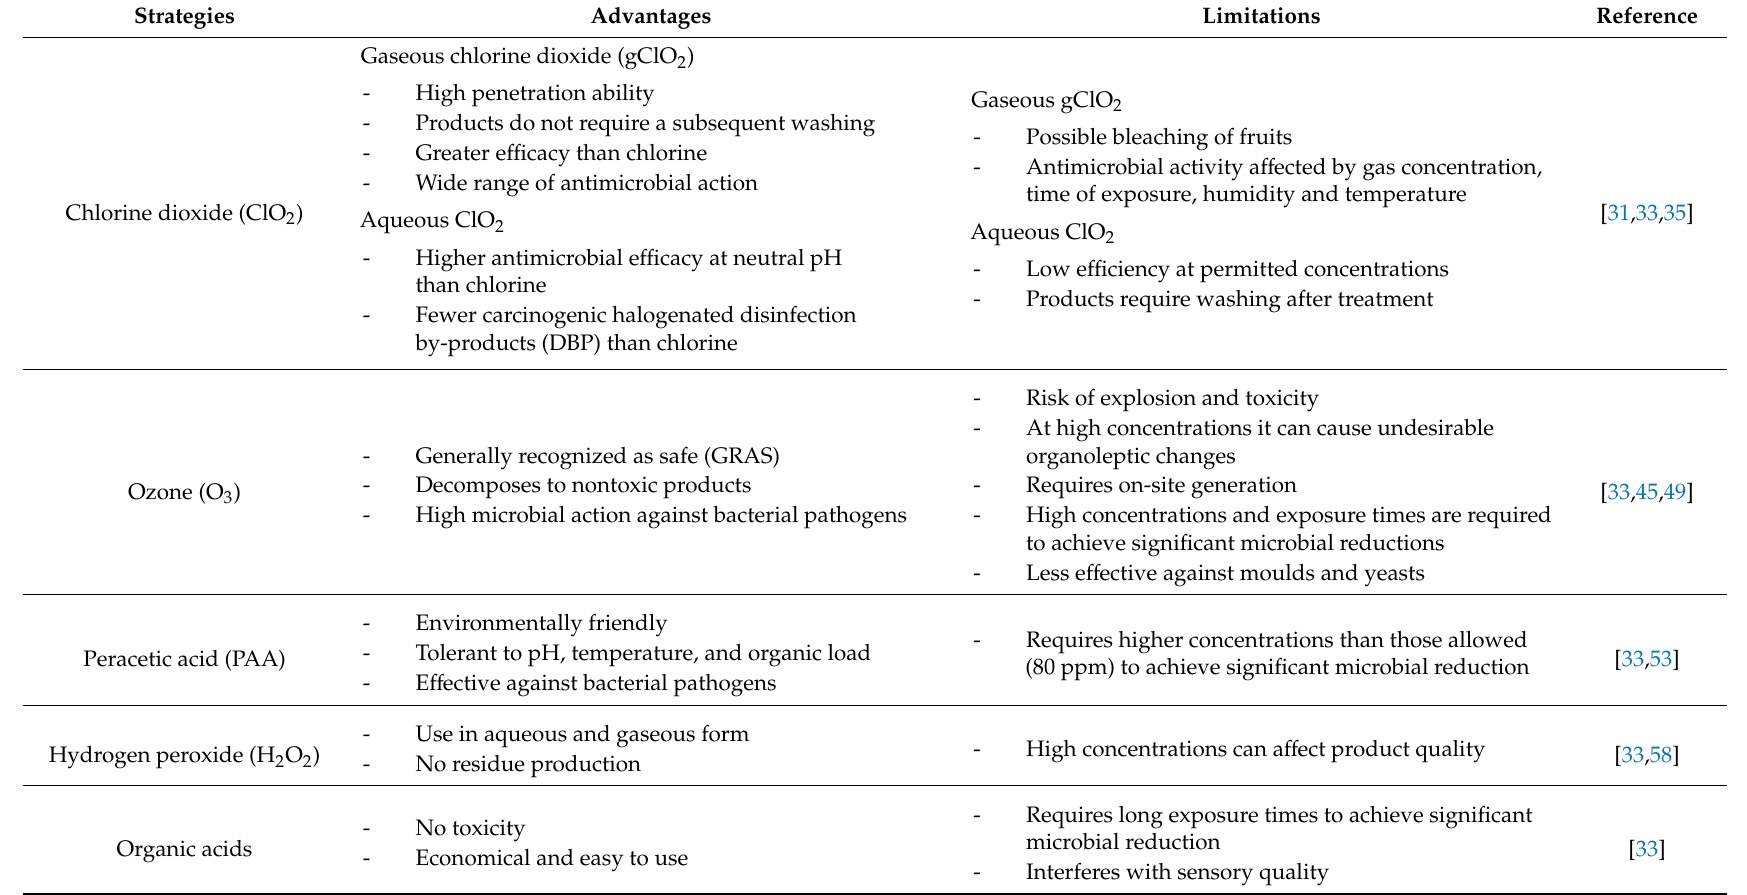
Table A1. Main advantages and limitations of strategies for the control of microorganisms on fresh blueberries and products derived